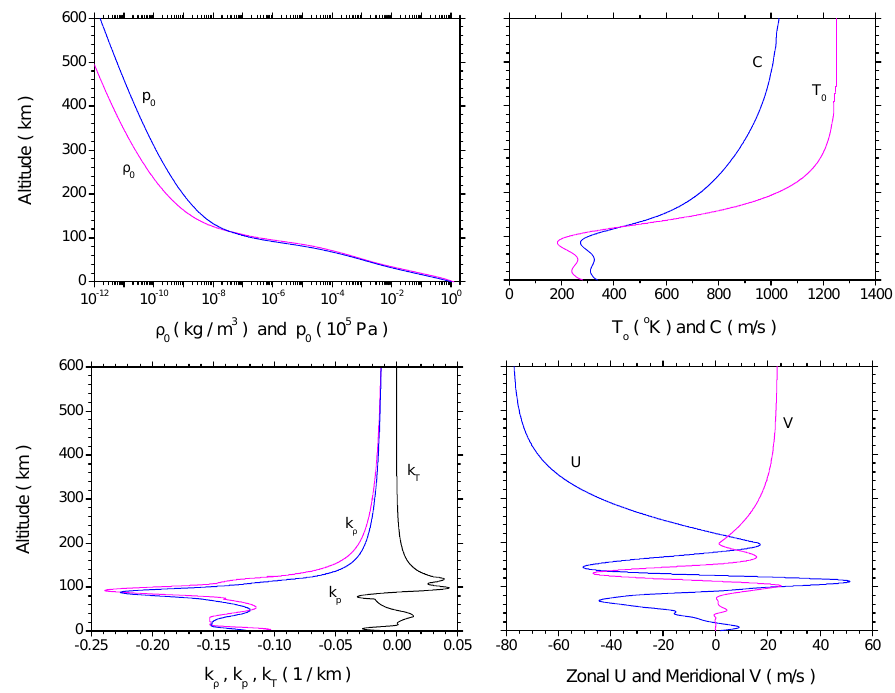
Figure 1. Vertical profiles of the atmospheric mean-field properties from NRLMSISE-00 and HWM93. Upper left: mass density ρ T (pink) and sound speed C (blue); lower left: density scale number k 0 number k (blue), and temperature scale number k p wind U (blue) and meridional (northward) wind V